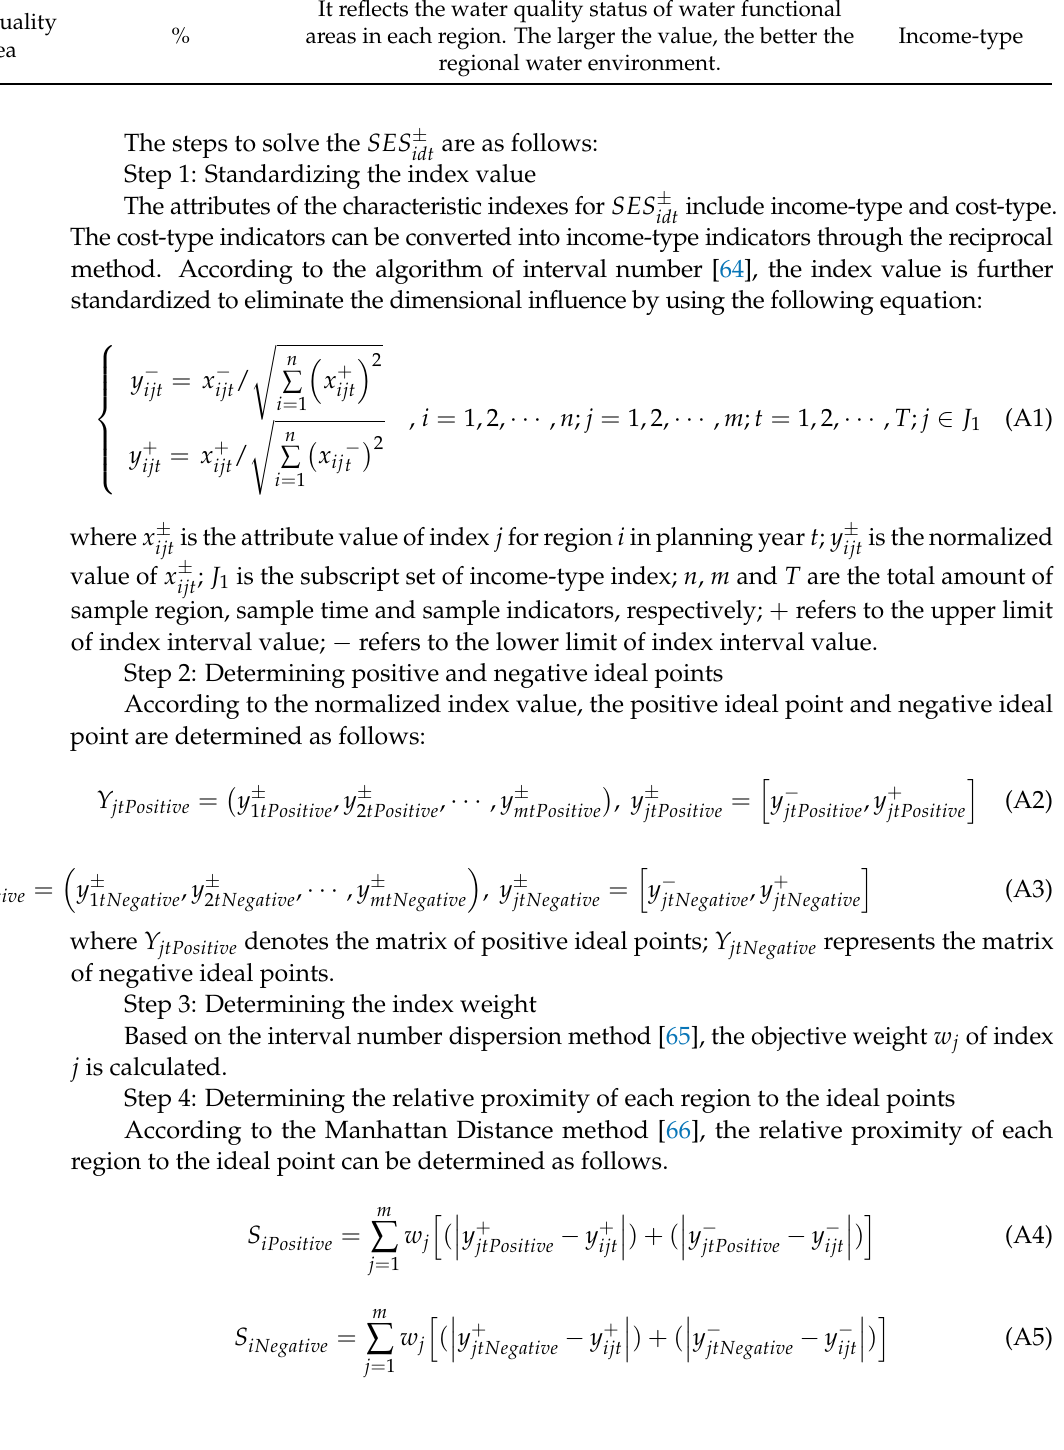
capacity of the